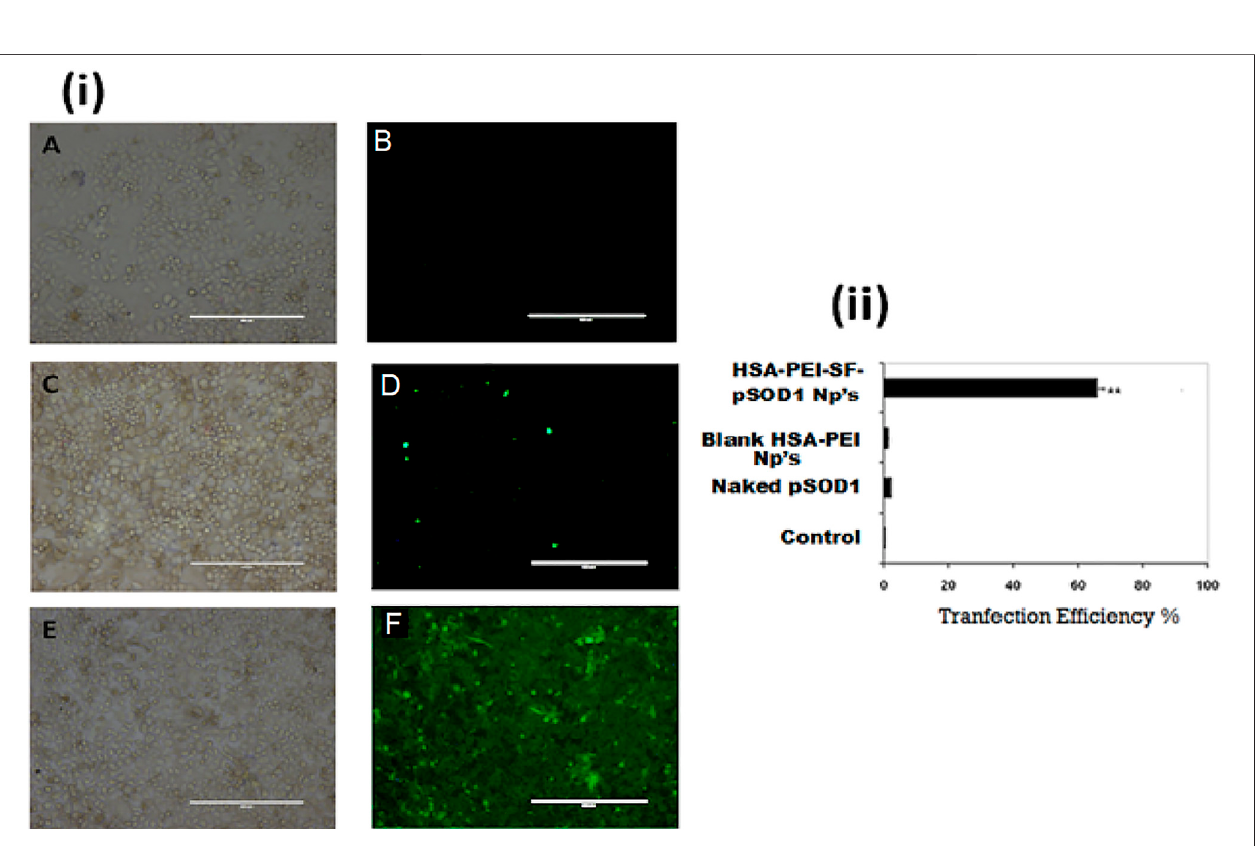
Frontiers in Cell and Developmental Biology |